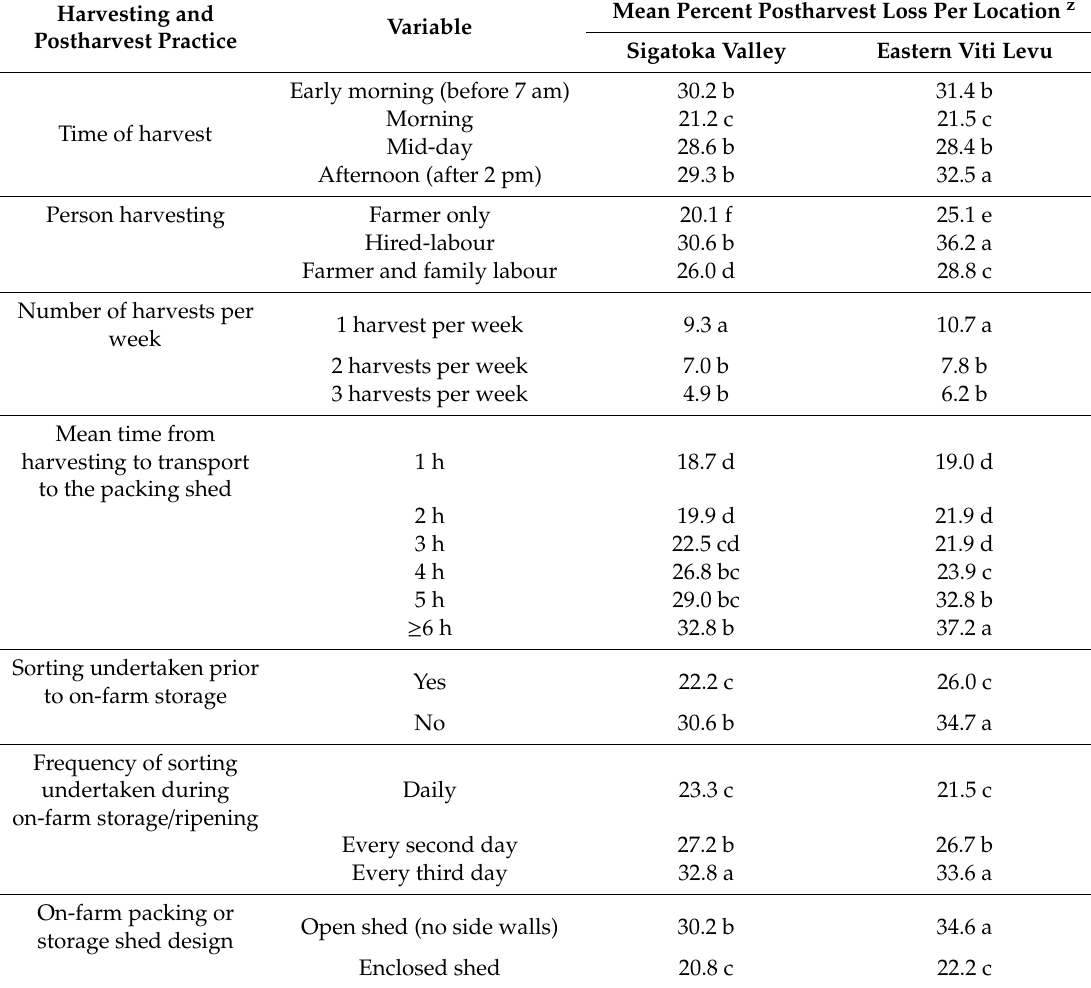
Table 5. Mean percent postharvest loss z associated with current postharvest handling practice for Sigatoka Valley and Eastern Viti Levu tomato value